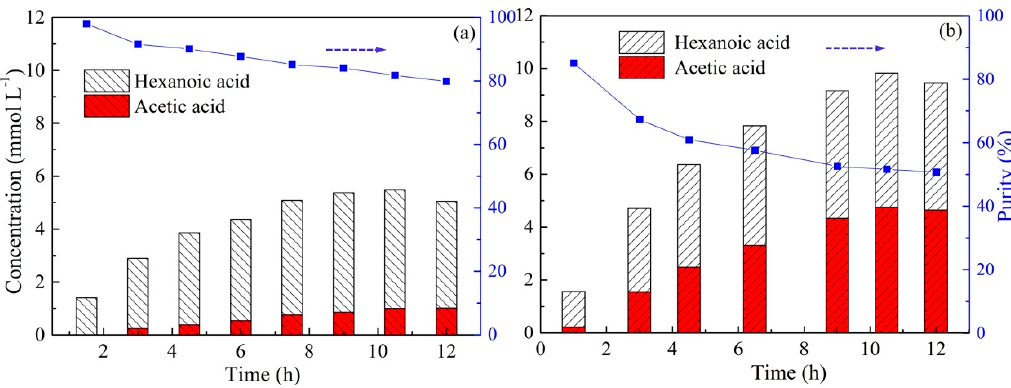
Figure 9. The changes in VFA concentration in the stripping solution with different types of stripping solution (PIMs: PIM4; Feed solution: 0.01 mol L − 1 acetic acid + 0.01 mol L − 1 hexanoic acid, pH = 6; Stripping solution: ( a ) 0.05 mol L − 1 HCl; ( b ) 0.05 mol L − 1 Na 2 CO 3 ).